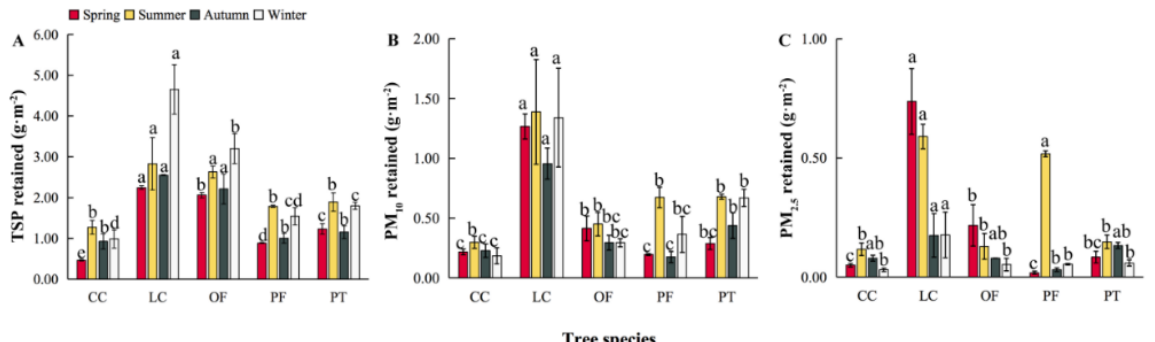
Figure 2. Foliar particulate matter retention of different plants. Note: ( A ) TSP, ( B ) PM 10 , ( C ) PM 2.5 , CC: Cinnamomum camphora (L.) Presl; LC: Loropetalum chinense var. rubrum Yieh; OF: Osmanthus fragrans (Thunb.) Loureiro; PF: Photinia × fraseri Dress; PT: Pittosporum tobira (Thunb.) Ait. Different lowercase letters in the figure indicate significant differences among different tree species in the same season ( p <